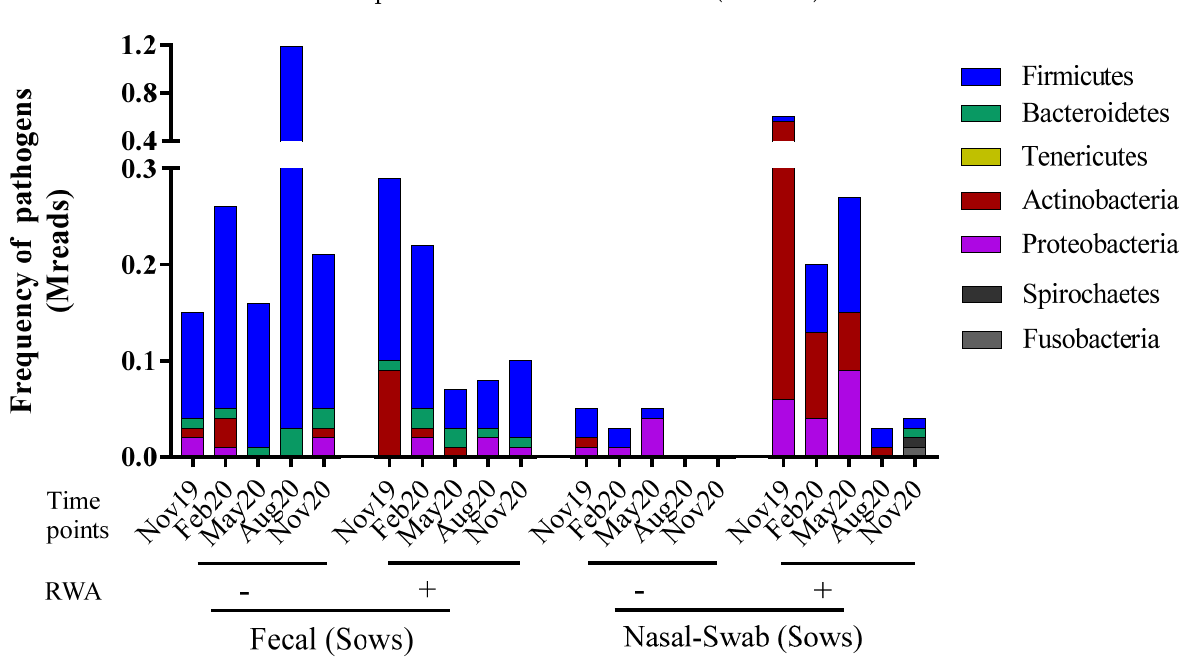
Figure 1. Metagenomic taxonomy profiling at the phylum level from sow feces and nasal swab samples collected from non-RWA − (minus sign) and RWA + (plus sign) barns. The stacked bars represent the average frequency of the major bacteriomes from each type of barn.